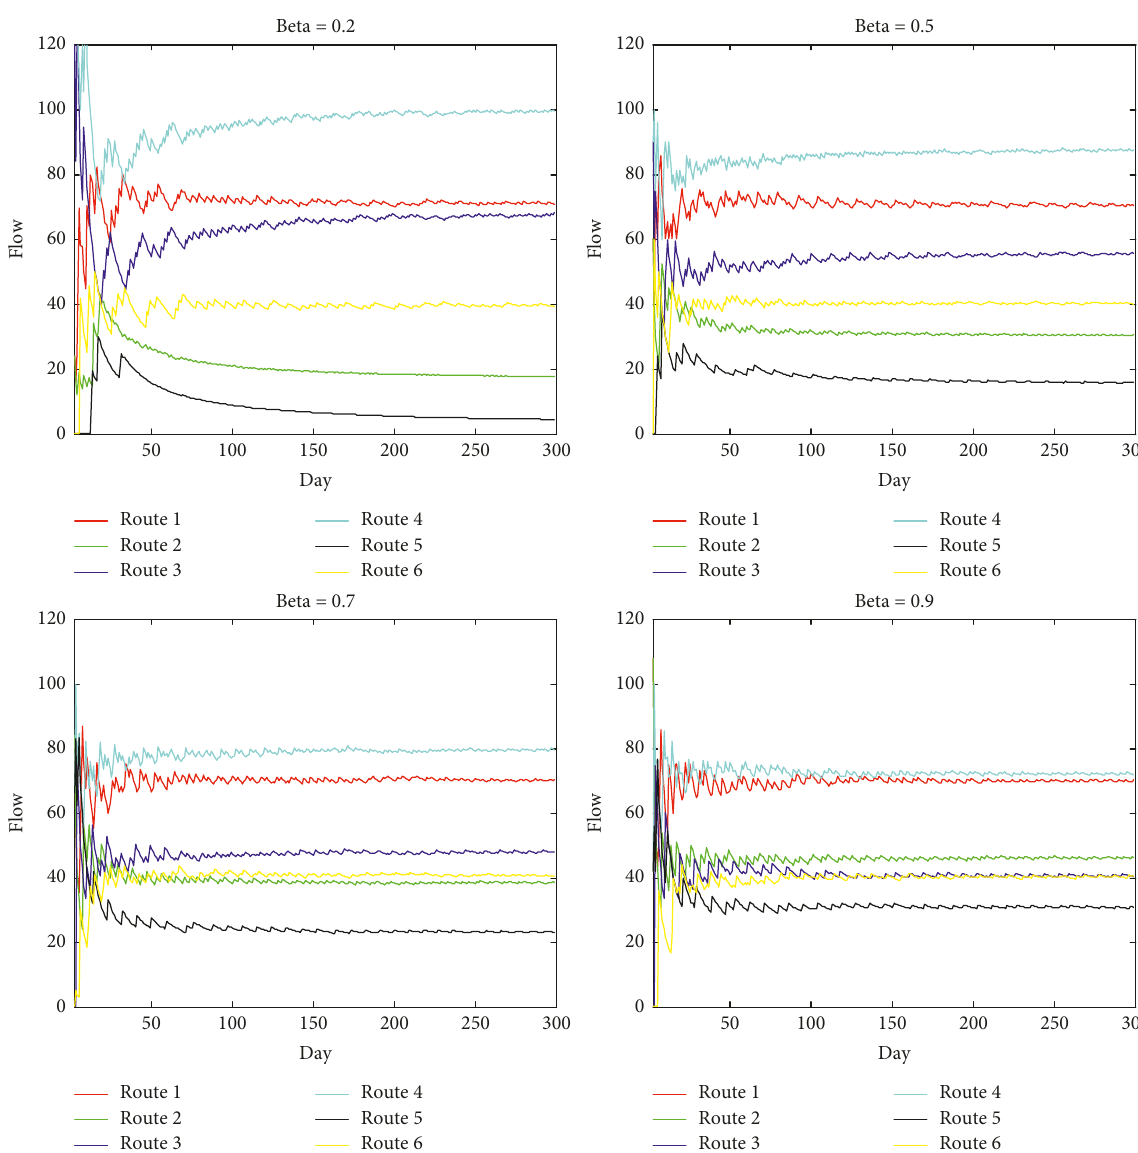
Figure 2: Flow evolution of test traffic network with different quantity adjustment ratios. Table 3: Route flow and cost in equilibrium.